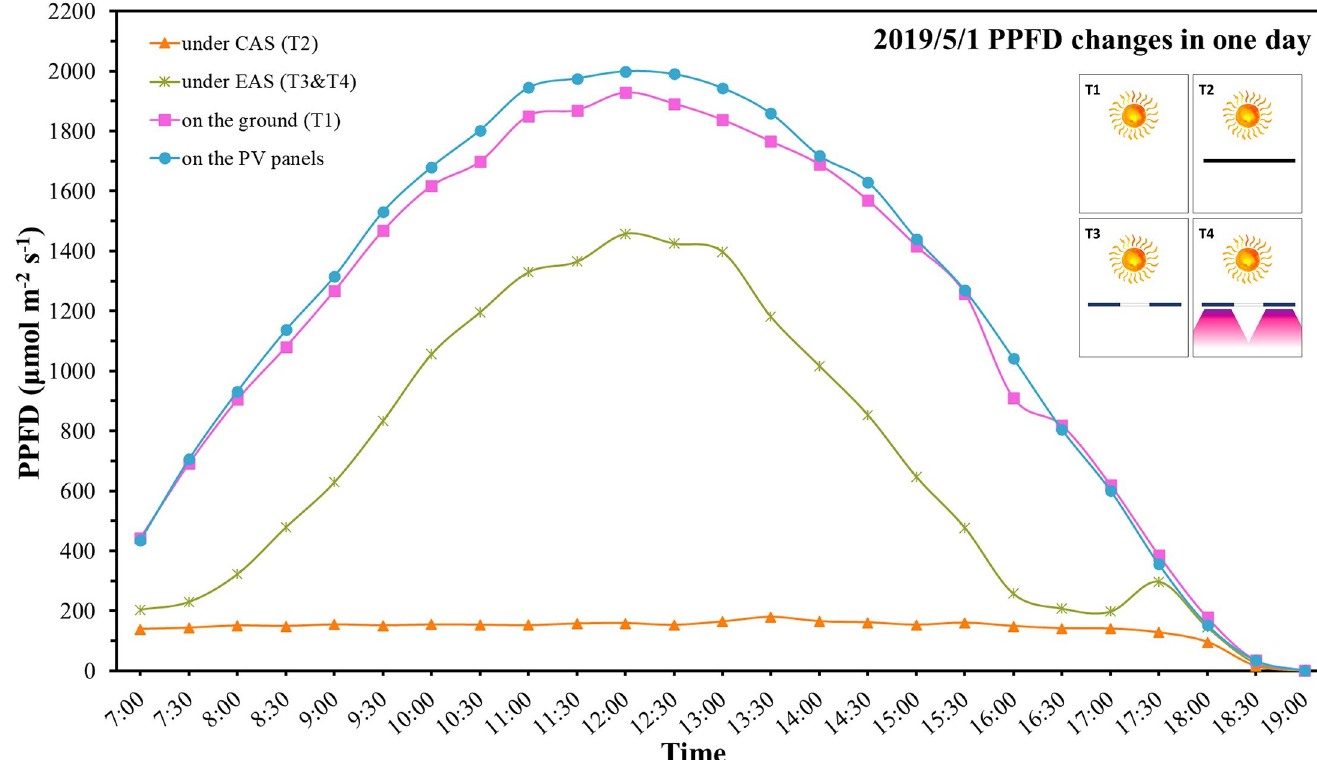
Fig 5. Variation of the typical light environment (PPFD) of different treatments over time. The detailed caption of legends is shown in Section 2.4.